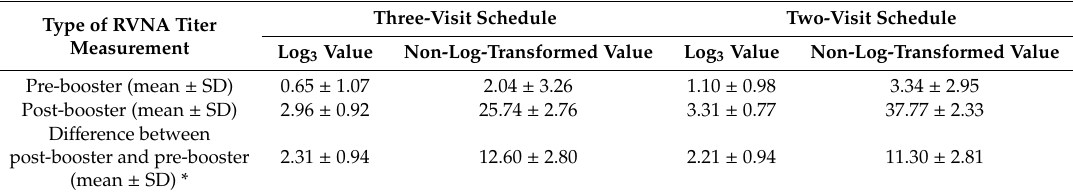
Table 1. Mean rabies virus neutralizing antibody (RVNA) titer values for the different vaccination schedules before and after revaccination.